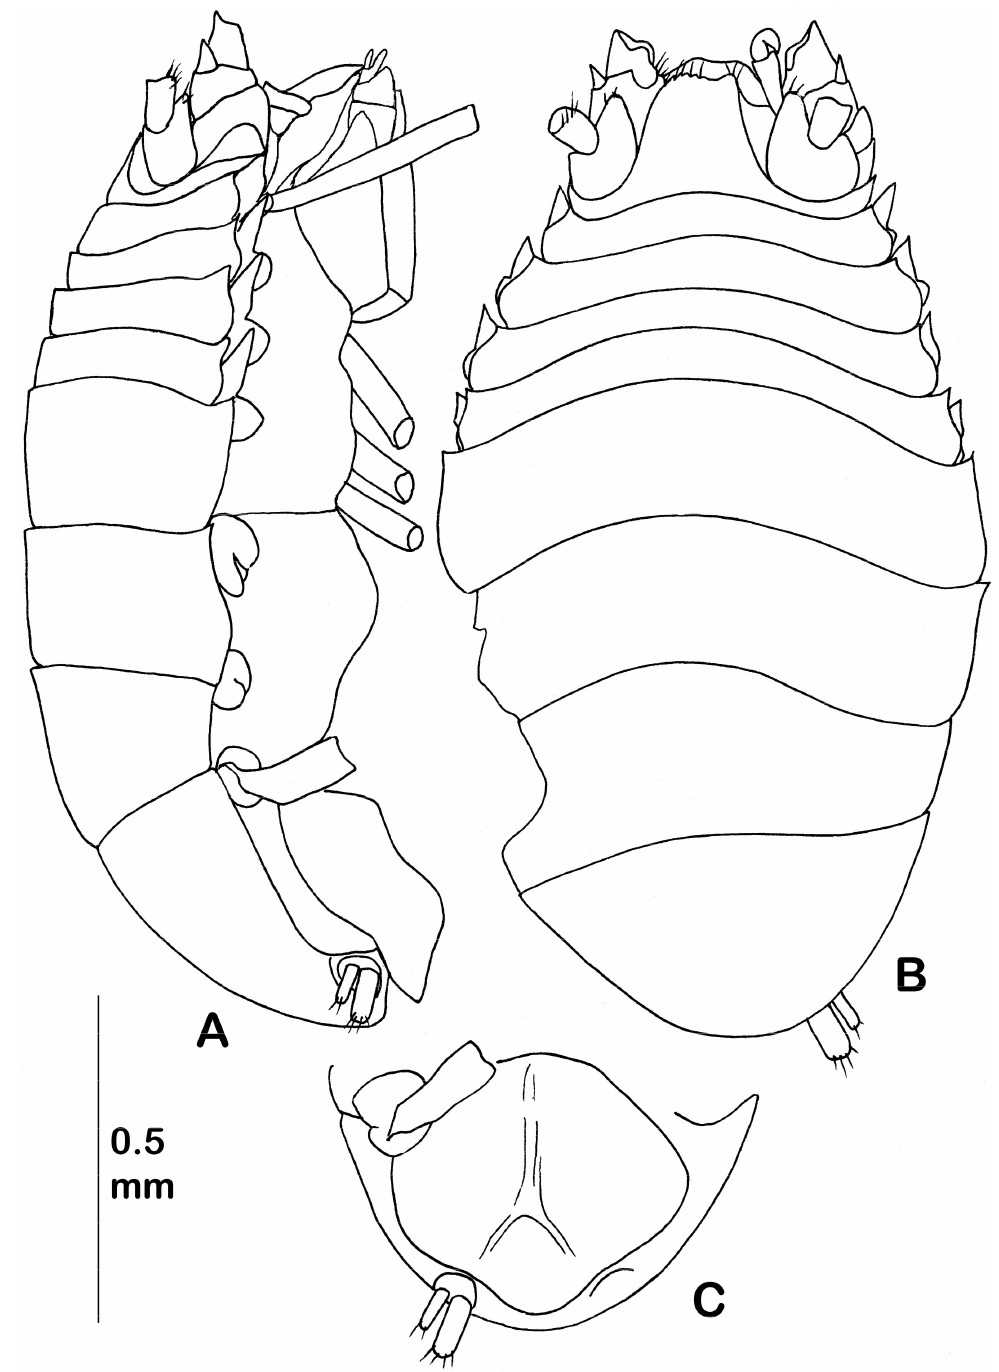
Figure 35. Eurycope mathiasi sp. nov. Female holotype (ZMH K-45660): ( A ) lateral view; ( B ) dorsal view; ( C ) pleotelson ventral